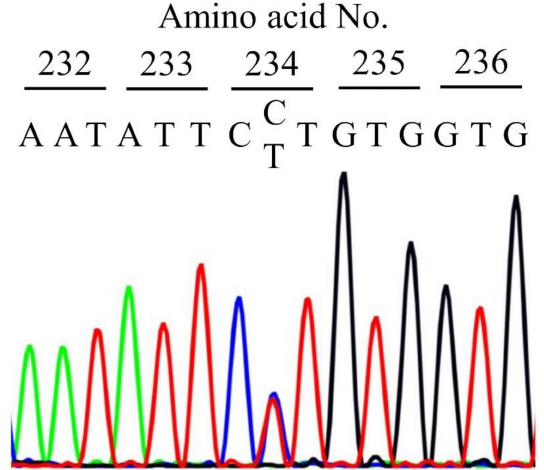
Figure 1. DNA sequence of proposita. The DNA sequence around the mutation position in FGB exon 4 is shown. A heterozygous variant c.701C > T was identified (B β p.P234L). Green: adenine (A), red: thymine (T), black: guanine (G), blue: cytosine (C).